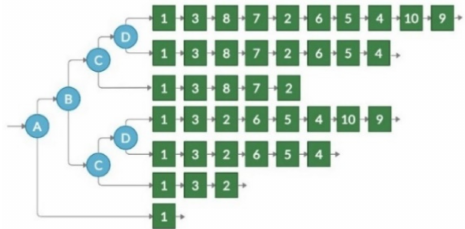
Figure A1. Result of original contextual graph transformation to Practice tree for graph, presented in Figure 9.